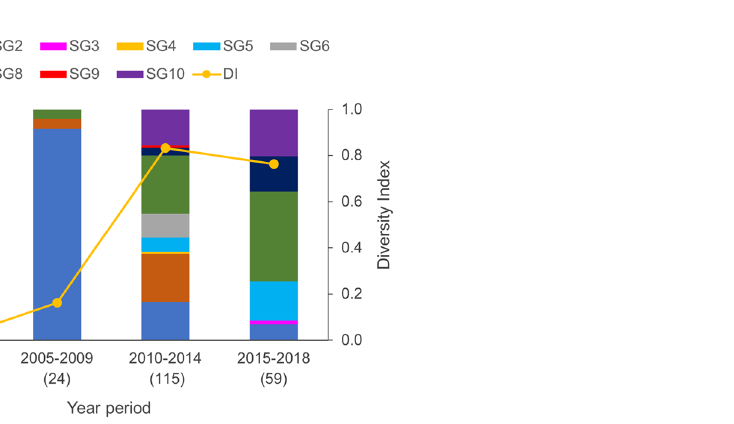
Figure 2. Maximum parsimony tree of 51 Bordetella pertussis MT27 isolates based on whole-genome SNPs. A total of 254 SNPs were identified among 51 genome-sequenced MT27 isolates using CSI Phylogeny 1.4. The radial tree was constructed using MEGA7. SBE-based SNP genotypes are highlighted by different colors. Scale bar indicates SNPs.